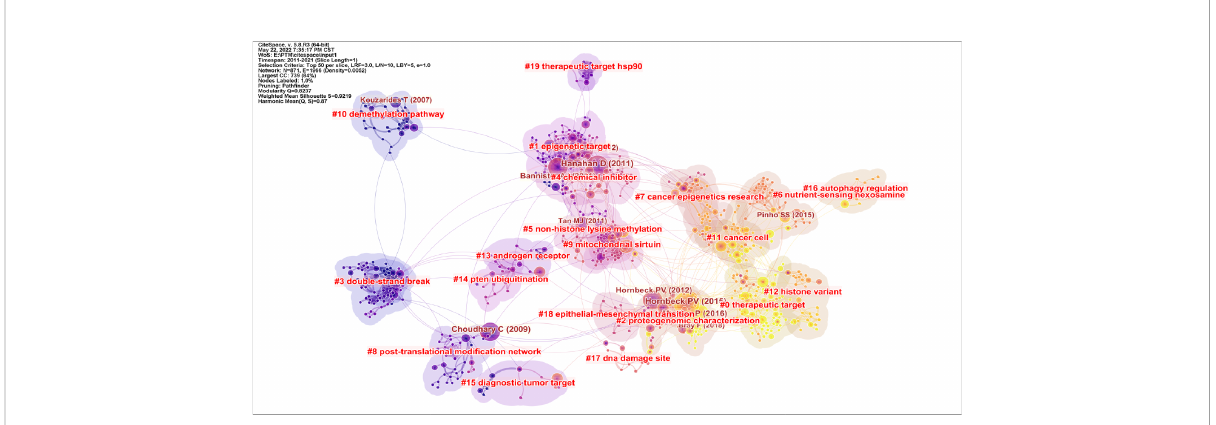
FIGURE 7 Cluster plot of the co-cited references. Source: authors with CiteSpace. Different colors represent different clusters and each cluster was composed of several closely related studies. The order is 0-18. The smaller the number, the more literature is contained within the cluster. Modularity indicates the modularity of clustering, and the closer it is to 1, the better the clustering result of the network. Silhouette value is used to measure the homogeneity of the network. The closer it is to 1, the higher the homogeneity of the cluster is.